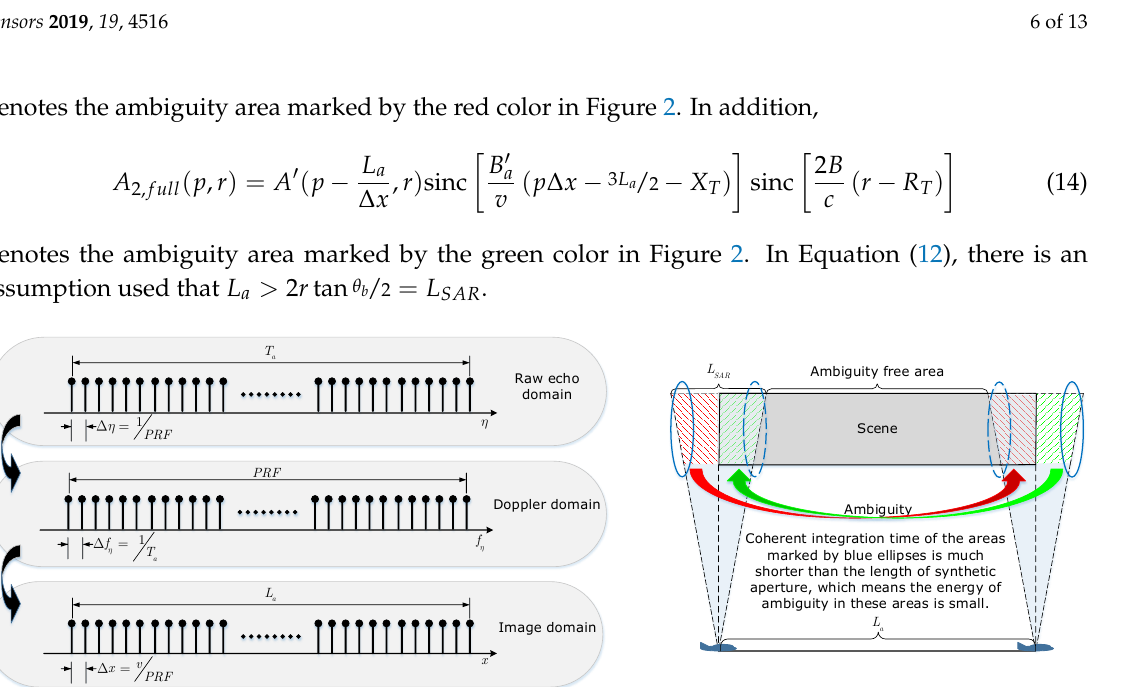
Figure 2. Full aperture processing. ( Left ): relationship between different signal spaces. ( Right ): full aperture observation geometry.